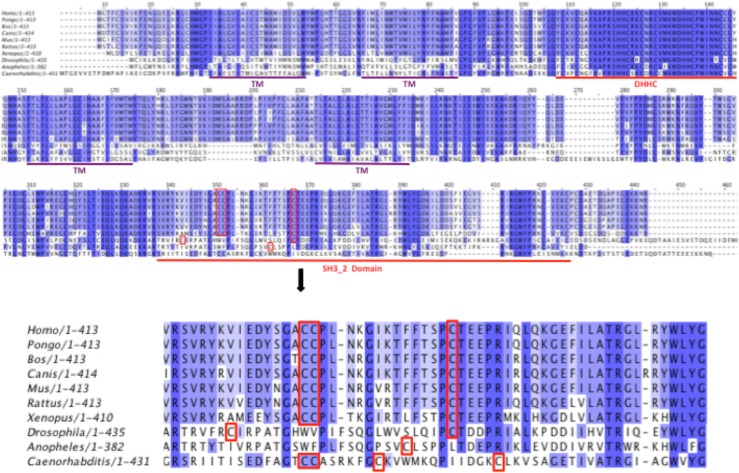
Alignment of DHHC6 sequences from different species.Identical amino acids are highlighted by dark blue. Palmitoylated cysteines are highlighted in red boxes. SH3-2 like domain and DHHC domains are underlined in red.